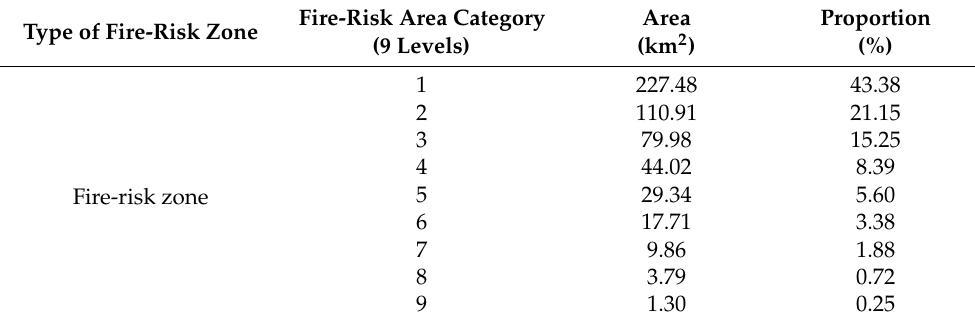
Table 8. Area and proportion of fire-risk